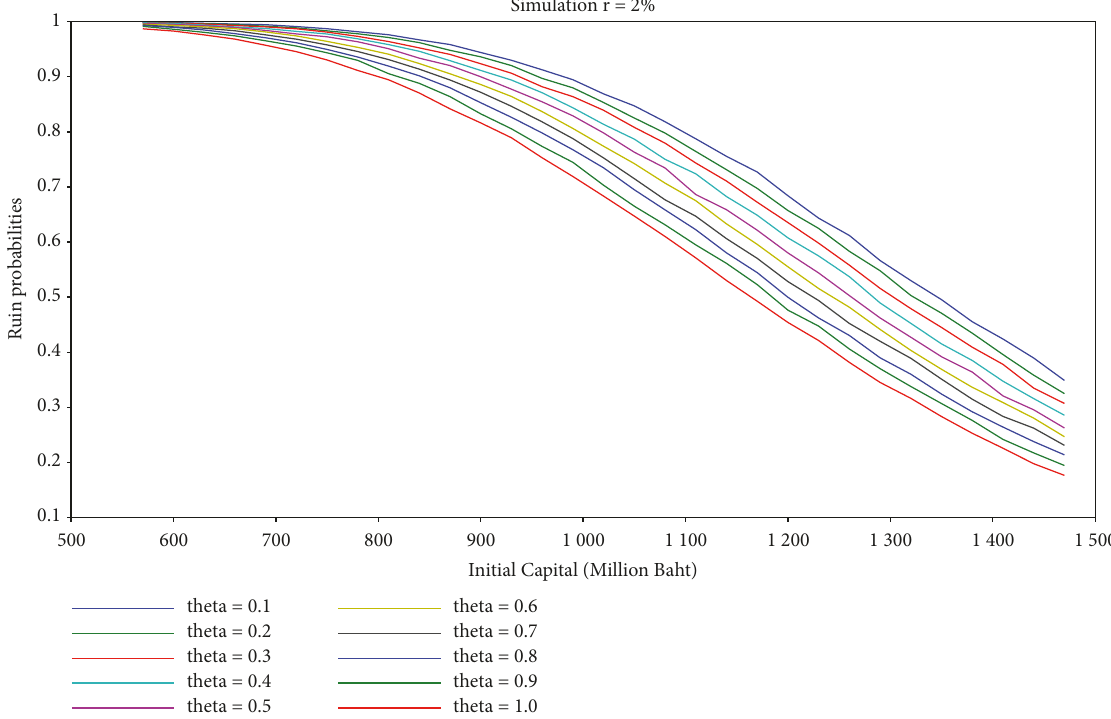
Figure 3: The relation between the initial capital and the ruin probability in the case of 𝑟 = 2 %.